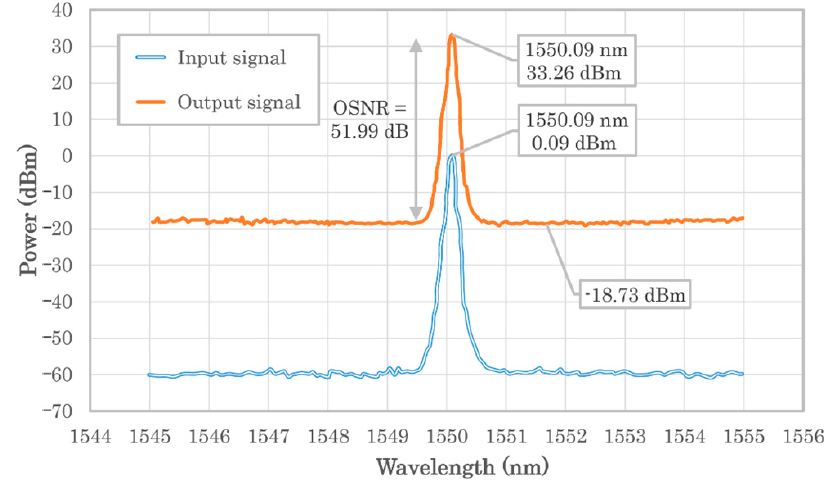
Figure 4. Spectrum-analyzer measurement of the 2-W EDFA.